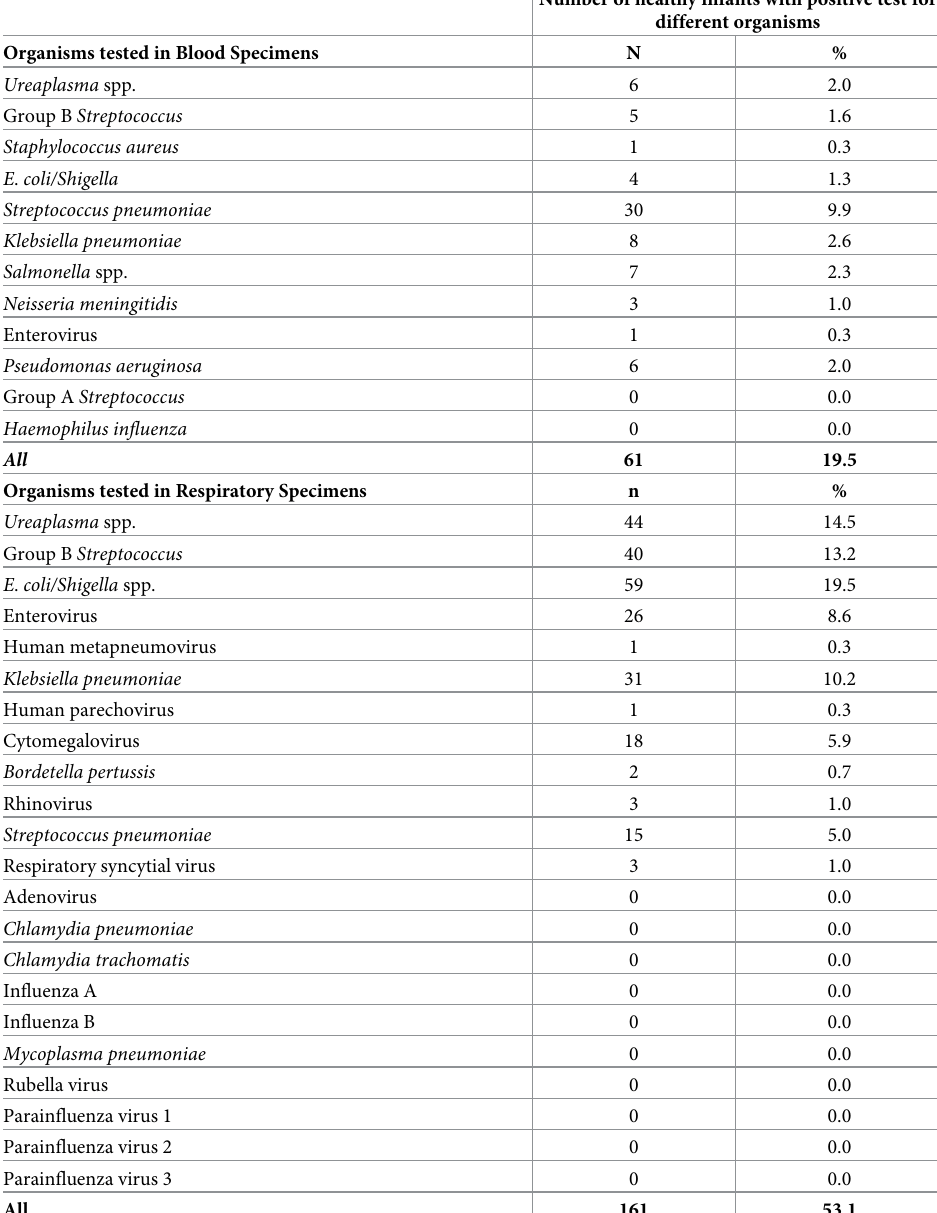
Number of healthy infants with positive test for different organisms